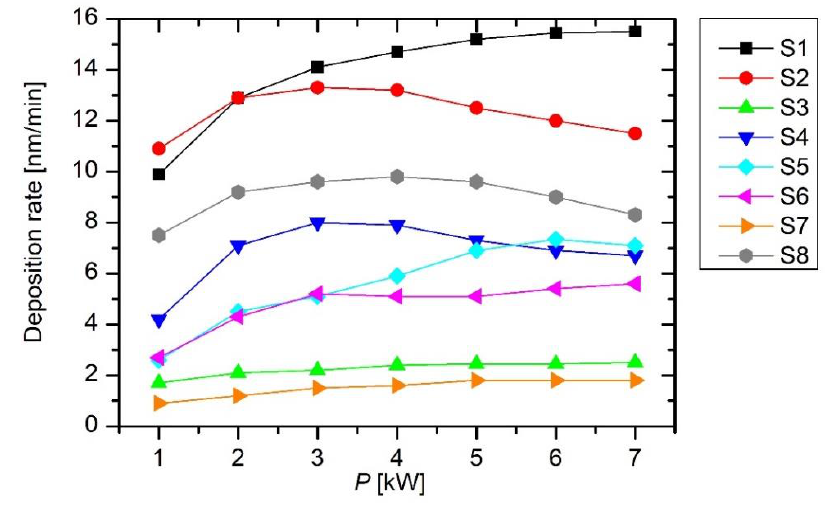
Figure 5. The deposition rate versus the discharge power in the empty reactor.